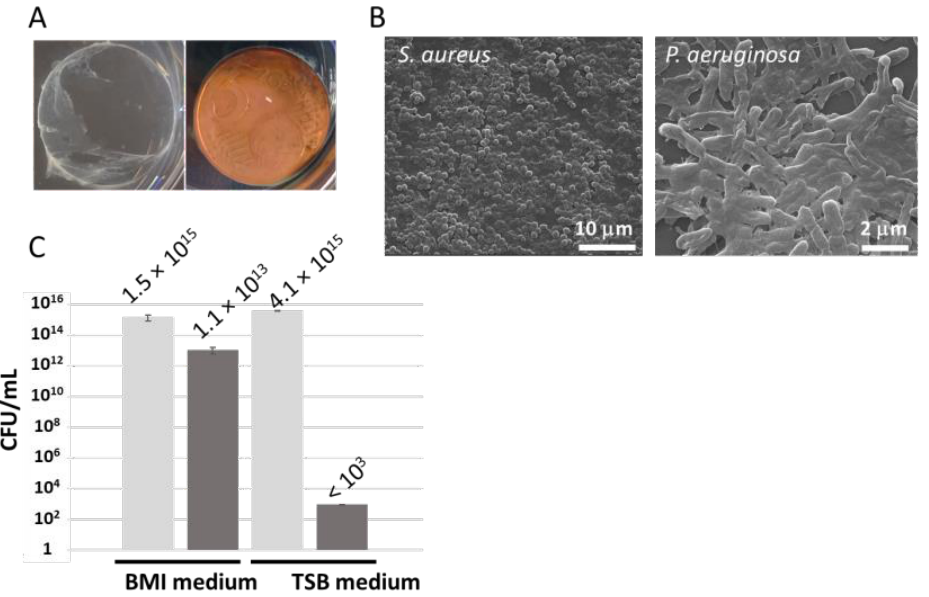
Figure 1. ( A ) Visual aspect of surfaces (glass token: left; 5 cent Euro coin: right) after 24 h incubation with S. aureus . ( B ) Microscopy analysis of glass tokens after 23 h incubation with S. aureus (left) and P. aeruginosa (right). ( C ) Impact of the growth medium (BHI or TSB) on the biofilm development inhibition test performed in persistent contact with the P. aeruginosa inoculum. The CFU/mL obtained with negative control glass surface or positive control 5 cent Euro coin are shown in light grey and dark gray, respectively.